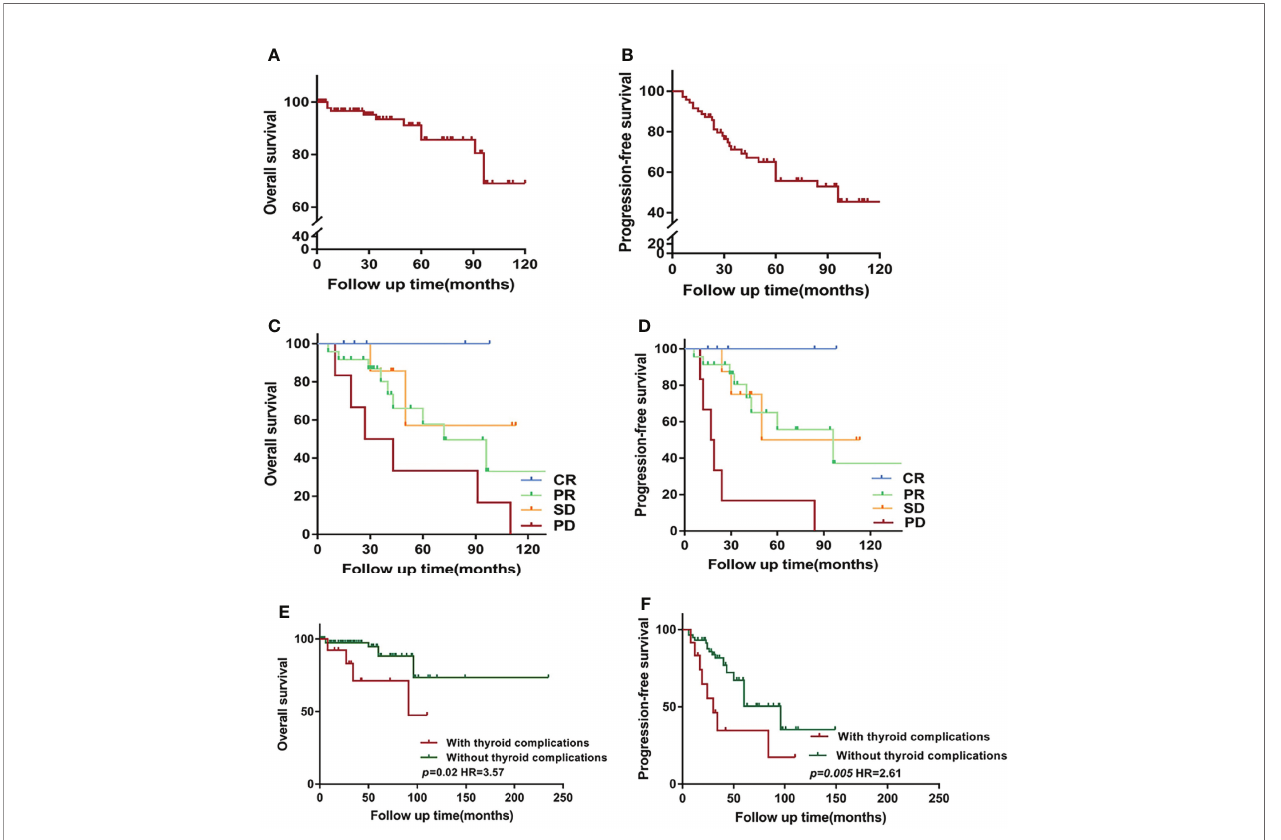
FIGURE 1 | Overview of survival in Waldenström macroglobulinemia/lymphoplasmacytoid lymphoma (WM/LPL) patients. (A) Kaplan – Meier curves of overall survival (OS) in all enrolled WM/LPL patients. (B) Kaplan – Meier curves of progression-free survival (PFS) in all enrolled WM/LPL patients. (C) Comparison of OS by the response to initial treatment. (D) Comparison of PFS by the response to initial treatment. (E) Kaplan – Meier curves of OS strati fi ed by thyroid complications. (F) Kaplan – Meier curves of PFS strati fi ed by thyroid complications. CR, complete response; PR, partial response; SD, stable disease; PD, progressive